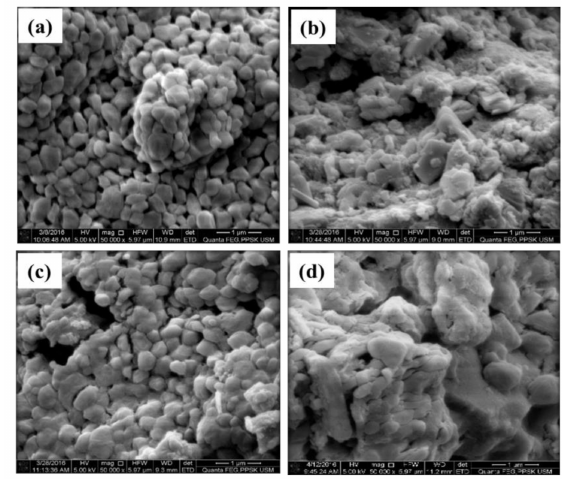
Figure 4. FESEM images of CaCO 3 using di ff ering feeding rates of K 2 CO 3 : ( a ) 1 h; ( b ) 1.5 h; ( c ) 2 h; and ( d ) 2.5